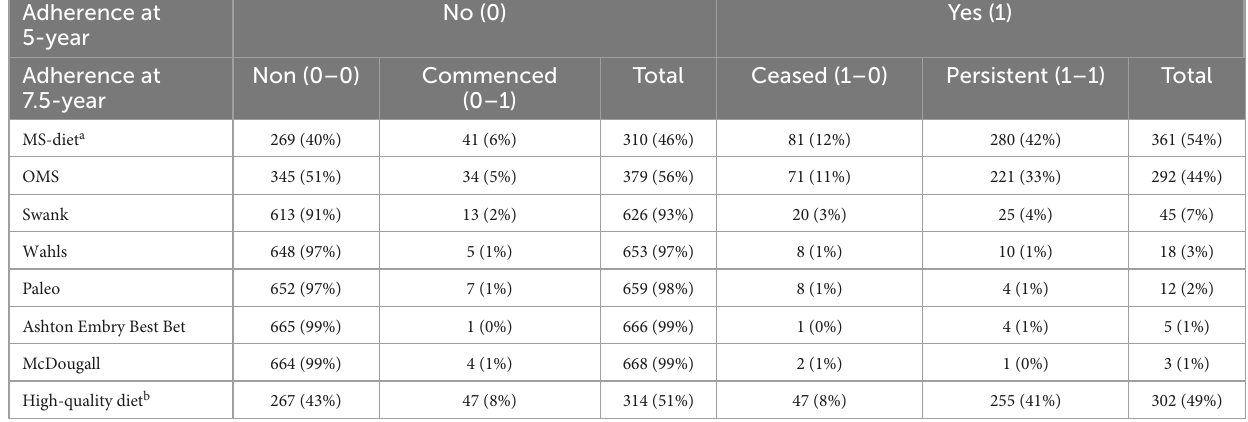
TABLE 2 MS-diet adherence from 5- to 7.5-year ( n = 671, 100%). Adherence at 5-year